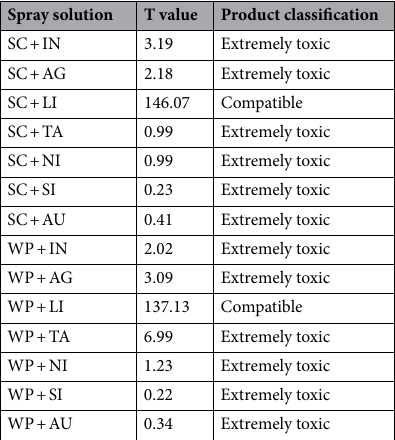
Table 1. T values for classifying the effects of adjuvants on Bacillus thuringiensis. SC suspension concentrate, WP wettable powder, AU AUREO, NI NIMBUS, IN IN-TEC, LI LI-700, TA TA35, SI SILWET, AG AGRAL, Bt Bt biopesticide.